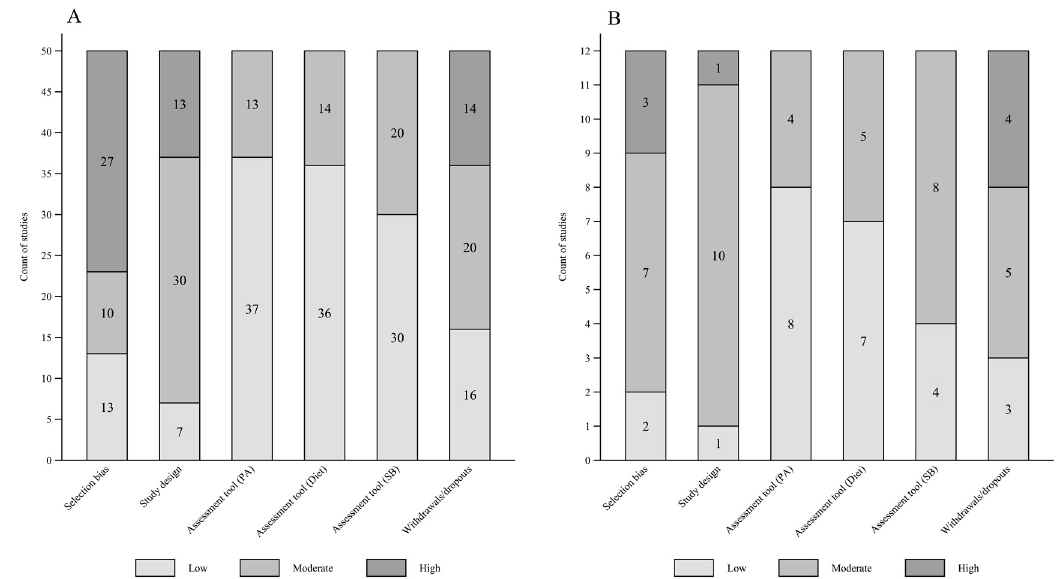
Figure 3. Risk of bias assessment of studies from high- ( A ), and middle-income ( B ) countries. All outcomes for PA, diet, and SB used in cluster procedures can be observed in Figure S2). The most common outcomes for PA were weekly PA ( n = 22 articles)